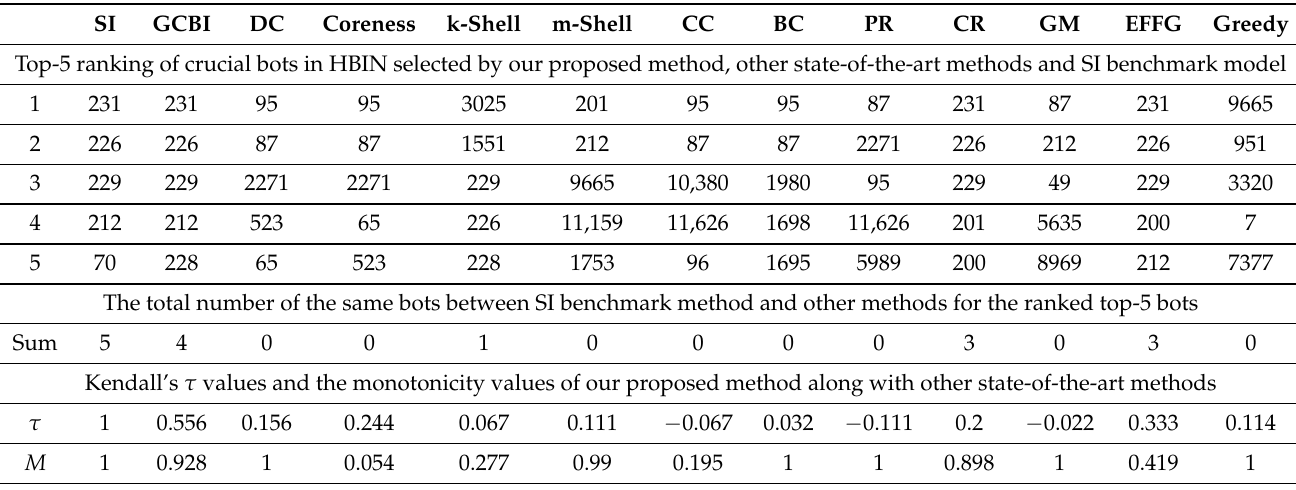
Figure 4. The figure compares the infection ability of the top-10 bot nodes selected by different methods in HBIN. Table 3. Comparison with baseline